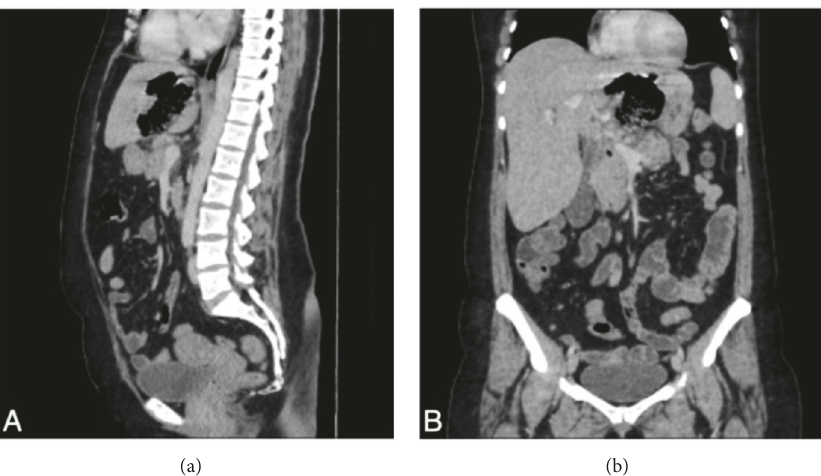
Figure 2: Sagittal (a) and coronal (b) abdominal CT scan with oral and IV contrast. Mixed collection containing air and debris measuring 8x7x5.5 cm is present. The lesion is spreading at the posterior aspect of the left lobe at segments II and III. Emphysematous changes of the adjacent parenchyma are